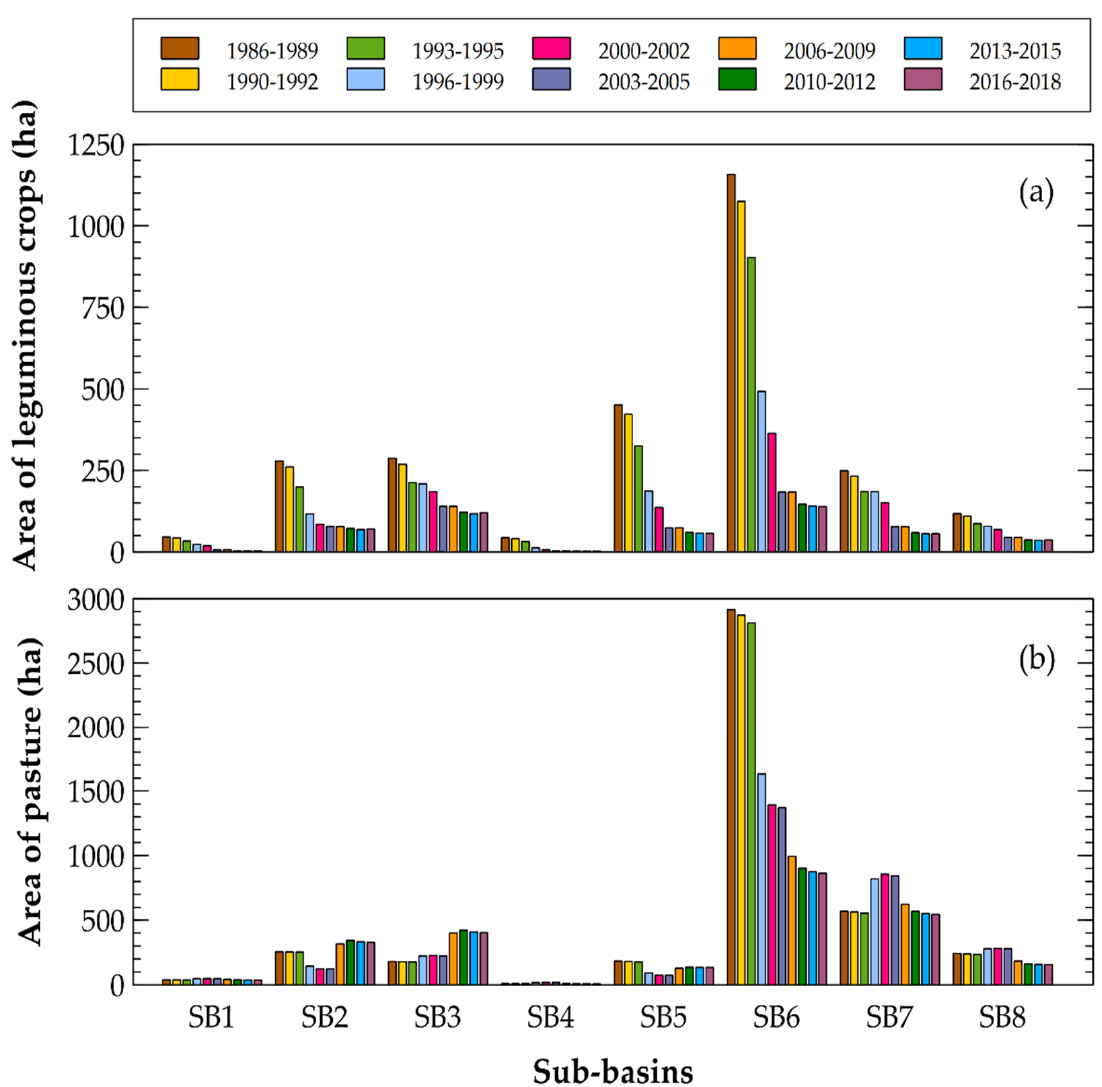
Figure 11. Cultivated areas of leguminous crops ( a ) and pasture areas ( b ) in Low Mondego.